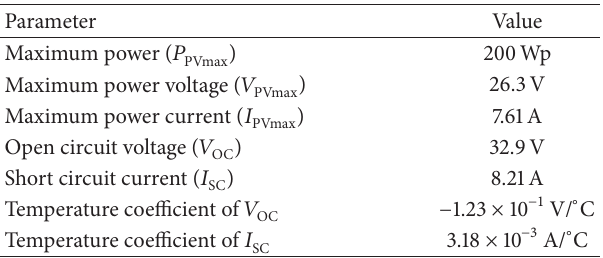
Table 3: Typical electric characteristics of PV module KC200GT